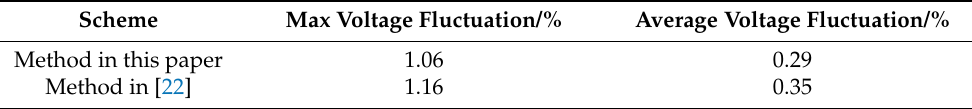
Table 7. Voltage fluctuation of distribution system upon power supply